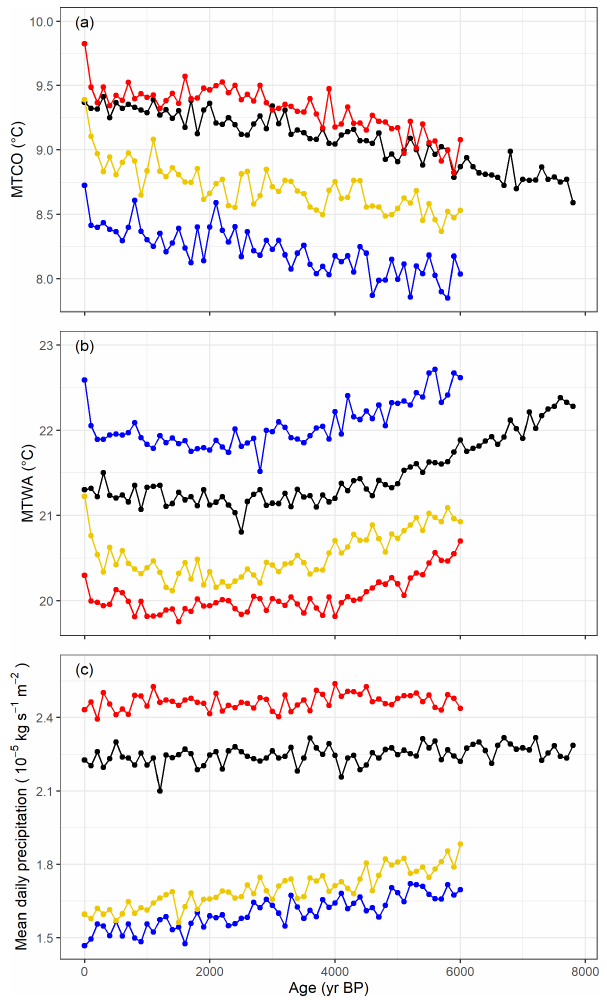
Figure 8. Simulated mean values of mean temperature of the coldest month (MTCO), mean temperature of the warmest month (MTWA) and mean daily precipitation in the Iberian Peninsula be- tween 8 and 0ka, smoothed using 100-year bins. Here, BP means before 1950AD. The black lines represent the Max Planck Insti- tute (MPI) Earth system model simulations, the red lines represent the Alfred Wagner Institute (AWI) Earth system model simulations, the blue lines represent the Institut Pierre-Simon Laplace Climate Model (IPSL-CM5) TR5AS simulations and the gold lines repre- sent the Institut Pierre-Simon Laplace Climate Model (IPSL-CM6) TR6AV simulations. The four simulations were forced by evolv- ing orbital parameters and greenhouse gas concentrations. The four models have different spatial resolutions, with the finest resolution being 1.875 ◦ × 1.875 ◦ (AWI, MPI) and the coarsest resolution be- ing 1.875 ◦ × 3.75 ◦ (IPSL-CM5,